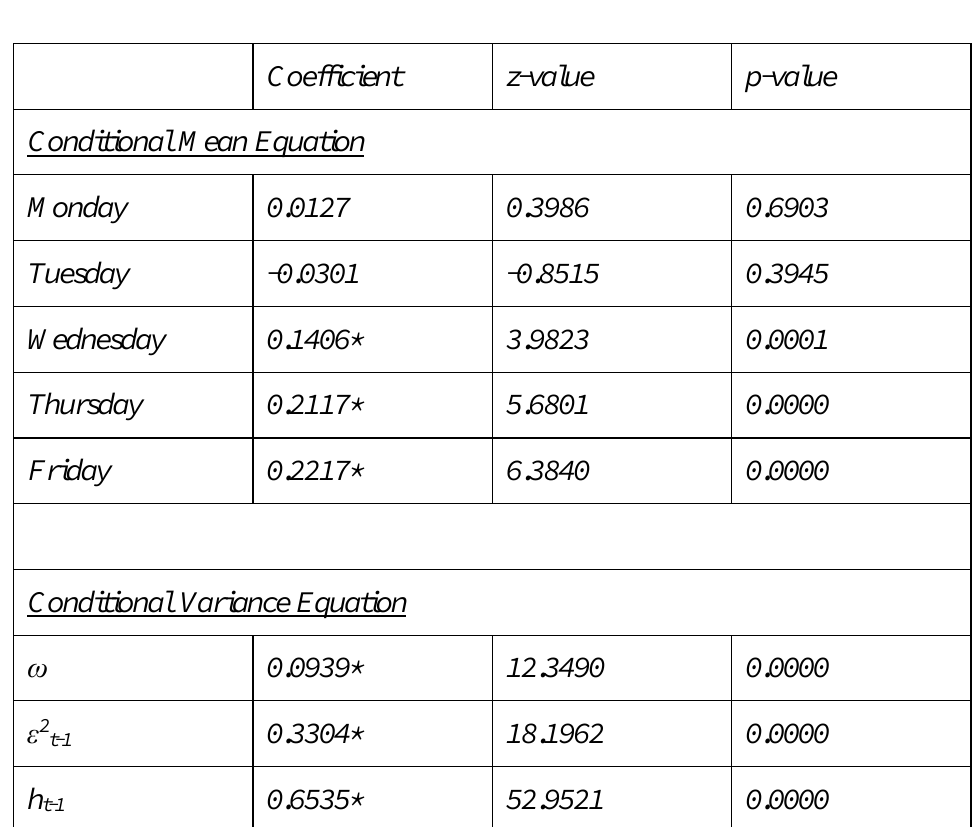
Table 3: GARCH model